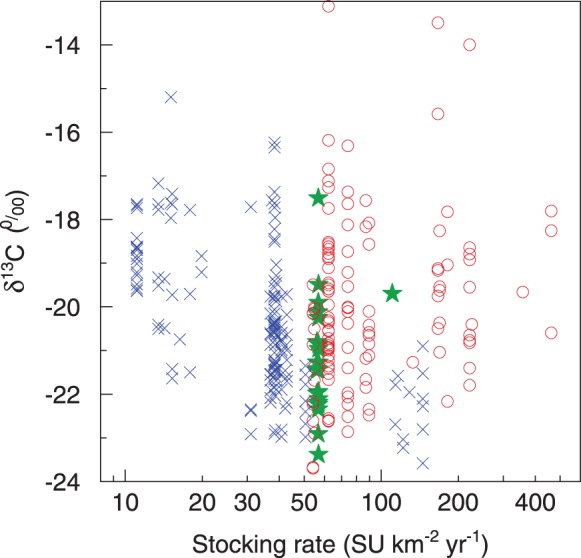
Carbon isotope ratio does not depend on stocking rate.Relative carbon isotope ratio (δ13C) in relation to stocking rate (log-scaled to increase readability) in different districts and years in Mongolia (blue crosses, all years; n = 152) and in Inner Mongolia prior to 2001 (green stars; n = 22) and after 2001 (red circles; n = 124).